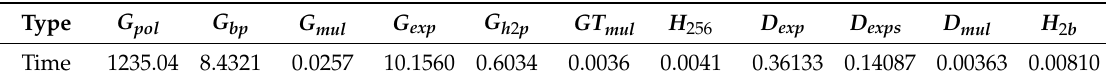
Table 8. Time cost of basic operations